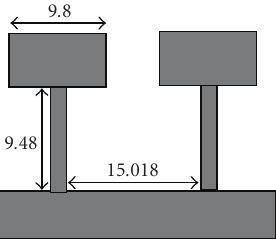
Figure 12: The shortened stepped impedance bandstop filter with dimensions in mm.